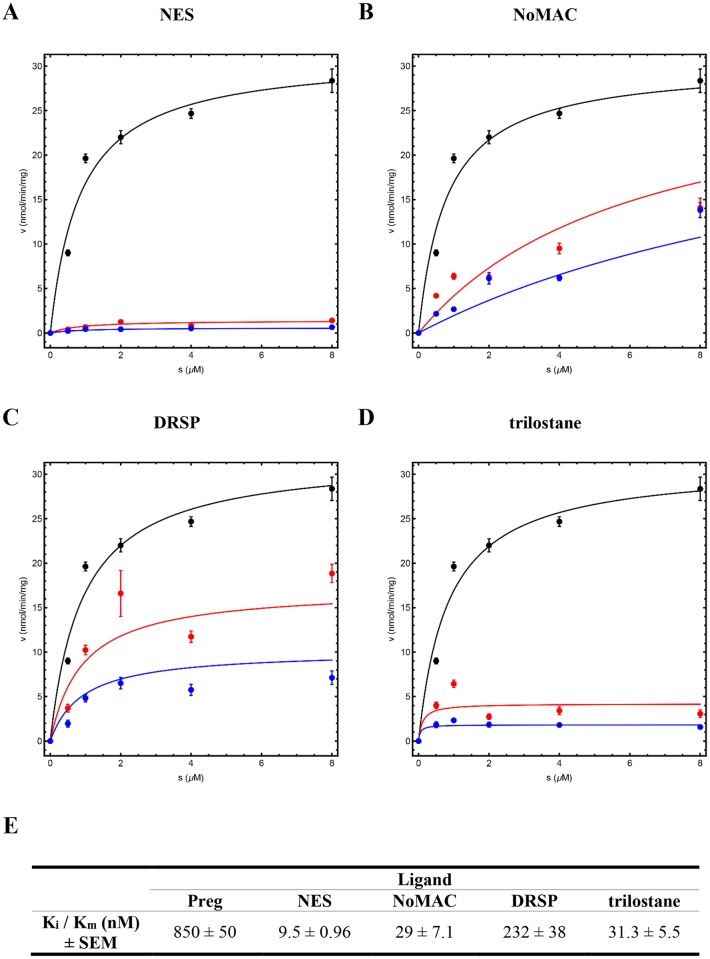
Inhibition of 3βHSD2 activity by NES, NoMAC, DRSP and trilostane.COS-1 cells were transiently transfected with a plasmid expressing human 3βHSD2 (pCDNA6-hHSD3β2-V5), and subsequently treated with increasing concentrations (0.5, 1, 2, 4 and 8 μM) of Preg (substrate) in the presence of 0.0, 0.2 or 0.5 μM (A) NES, (B) NoMAC, (C) DRSP or (D) trilostane. The conversion of Preg to Prog was analyzed using UPLC-MS/MS. Michaelis-Menten plots are shown in the absence (black symbols and lines) and presence of 0.2 μM (red symbols and lines) and 0.5 μM (blue symbols and lines) of NES, NoMAC, DRSP and trilostane. A Km of 0.85 ± 0.05 μM and Vmax of 31.1 ± 0.7 nmol/min/mg were obtained in the absence of inhibitor. Three inhihitory mechanisms were fitted (S2 Fig) and the best fit mechanism is shown. Each data point represents the mean ± SE of one experiment performed in duplicate. These results were validated by a model predicting 3βHSD2 activity in an independent experiment (S3 Fig, dashed green line).